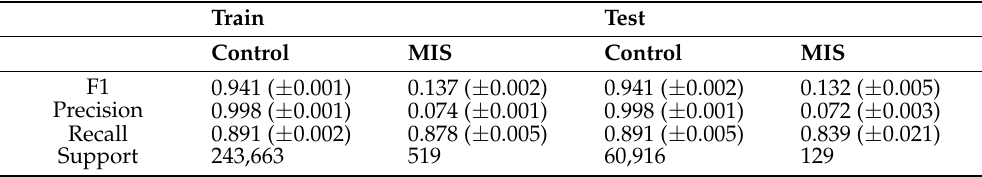
Figure 3. Receiver operating curve in training and testing during cross-validation. The area under the curve (AUC) is 0.946 in training and 0.931 in testing. Table 3. Performance metrics in the training and testing datasets of the five-fold cross-validation shown as mean ( ± standard